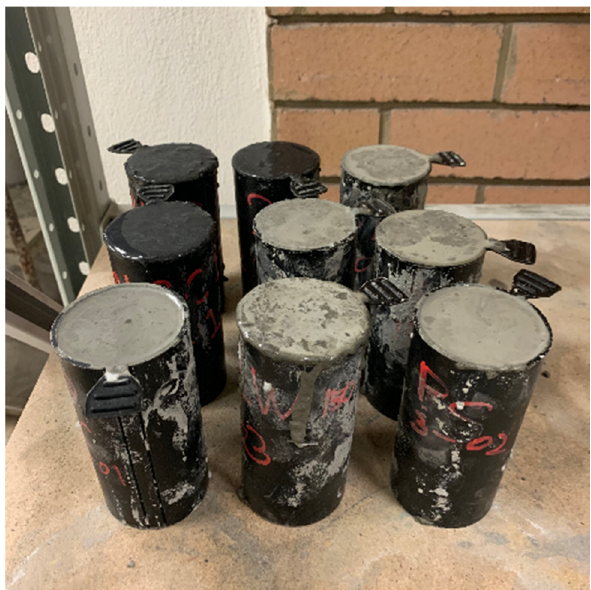
Figure 1: Specimens before demolding.